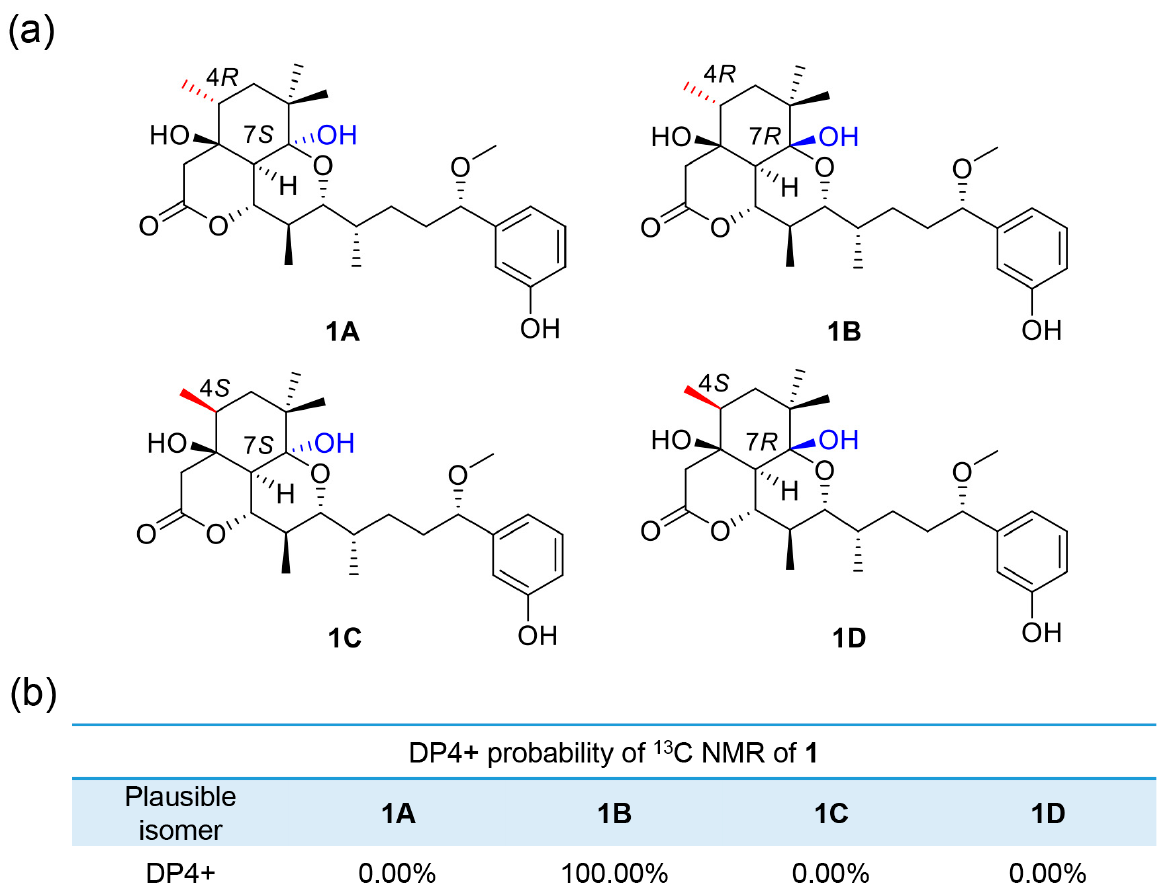
Figure 3. ( a ) Possible isomers for 1 . ( b ) DP4+ probability of 13 C values of 1 . Neo-debromoaplysiatoxin J ( 2 ) was isolated as a white solid. The molecular formula of C 32 H 46 O 11 with 10 degrees of unsaturation was inferred from HRESIMS data at m / z 629.2938 [M + Na] + (calcd. for C 32 H 46 O 11 Na, 629.2938). The NMR data of 2 exhibited a keto carbon ( δ C 207.2), two carbonyl carbons ( δ C 169.8 and 165.5), six aromatic carbons ( δ C 156.4, 143.5, 129.5, 118.4, 114.8 and 114.5), two oxygenated quaternary carbons ( δ C 105.7 and 87.2) and a methoxy ( δ C 56.7) (Table 1). The detailed interpretation of NMR spectra indicated that the planar structure of 2 closely resembles those of debromoaplysiatoxins, especially neo-debromoaplysiatoxin A (Neo-A) [10], except for C-2, C-4, C-7 and the atom composition of ring A, C. The HMBC correlations from H 2 -2 to C-1 and C-3; from H 3 -26 to C-3, C-4 and C-5; from H 2 -5 to C-3, C-4, C-6, C-7, C-25 and C-26; and from H 3 -24 and H 3 -25 to C-5, C-6 and C-7 decided the structural segment of C-1–C-7 (Figure 2). Considering the requirement of the unsaturation and the molecular formula for 2 , the C-4 ( δ C 87.2) and C-7 ( δ C 105.7) were linked through a peroxide bridge to form a relatively stable six-membered ring A. Besides, IR absorption bands for 877 cm − 1 suggested a peroxide bond [24]. 13 C chemical shifts of carbons in a similar chemical environment with C-4 and C-7 of 2 , such as C-3 ( δ C 105.4) of artemisinin [24], C-8 ( δ C 109.4) of hedychin A [25] and C-7 ( δ C 89.8) of talaperoxides B [26], verified the rationality of the chemical shifts